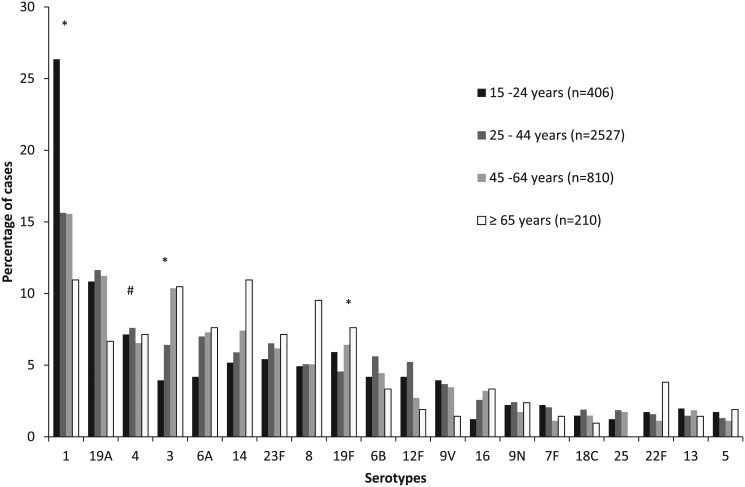
Distribution of pneumococcal serotypes amongst patients aged ≥15 years with invasive pneumococcal disease (IPD) in South Africa from 2003–2008, by age group.# Reference group. *Statistically significant at p<0.05.